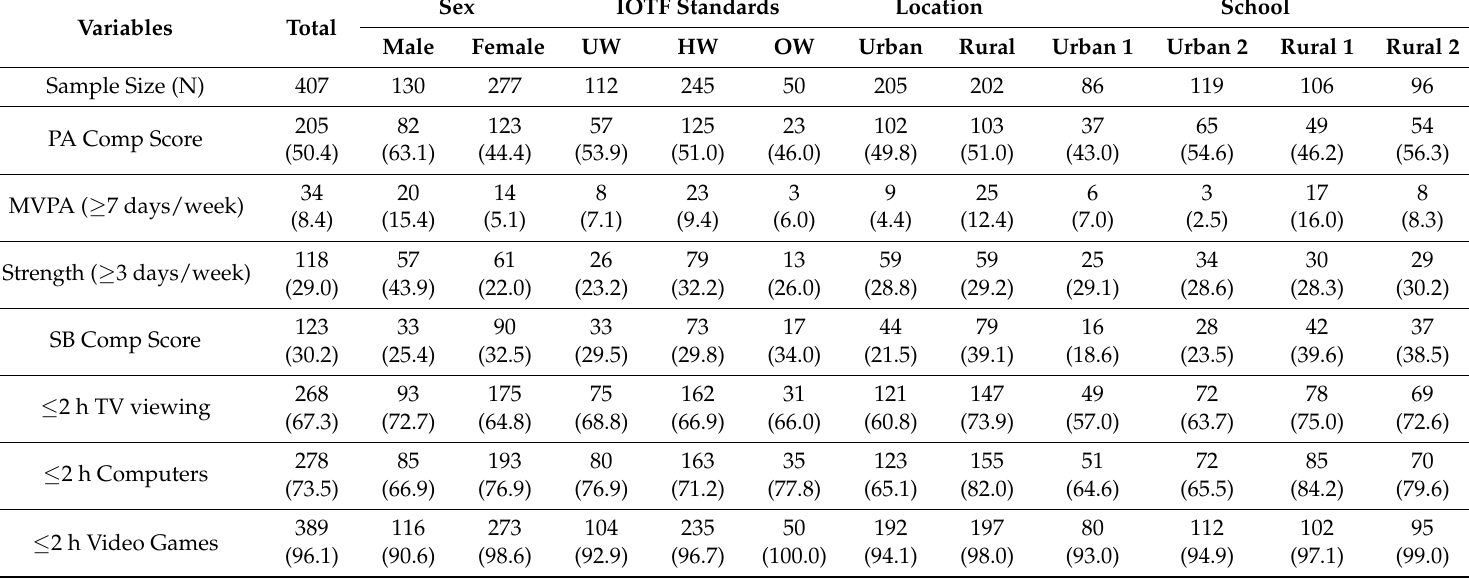
Table 3. Frequency of adolescents meeting the physical activity and sedentary guidelines. Number